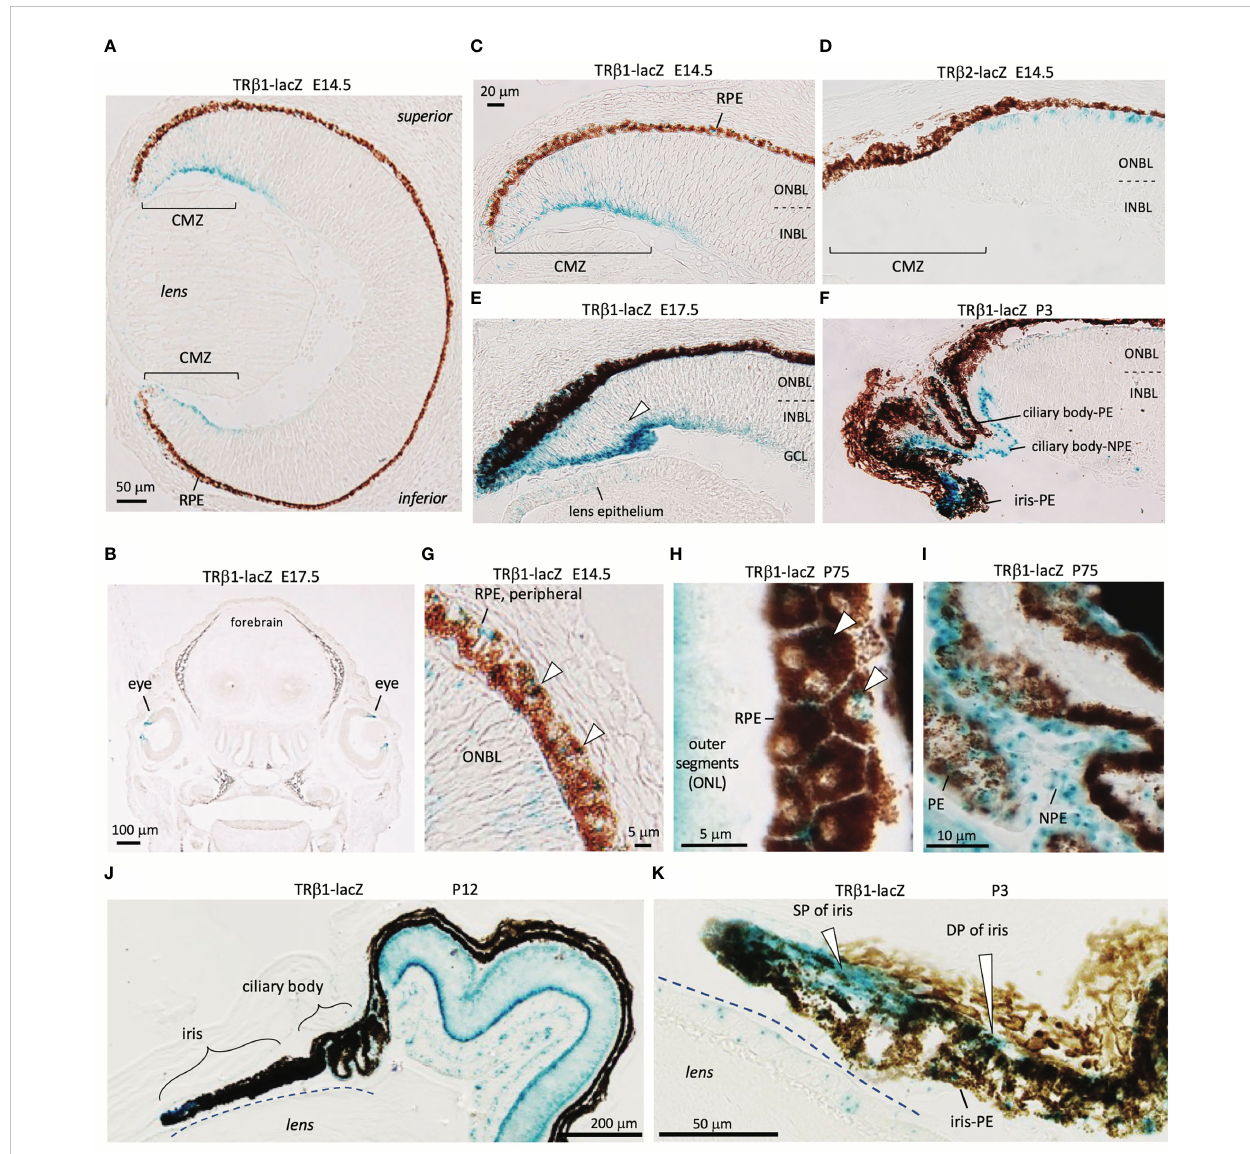
FIGURE 5 TR b 1 in the ciliary margin zone, iris and associated tissues detected in Thrb b1 lacZ reporter mice. (A, B) , TR b 1 in the ciliary margin zone (CMZ) (x-gal staining, blue) in Thrb +/b1 embryos. Otherwise, expression is rare in embryonic tissues (coronal head section in B ). (C, D) , Expression of TR b 1 in the CMZ contrasts with TR b 2 in cone precursors shown in Thrb b2/b2 lacZ reporter mice. (E) , TR b 1 in the late embryonic CMZ. Arrowhead, positive progenitor cells in the neuroblastic layers of the CMZ. Weak signals are detected in the lens epithelium. (F) , TR b 1 in the non-pigmented (NPE) and pigmented epithelia (PE) of the ciliary body at P3. (G, H) , TR b 1 in the retinal pigmented epithelium (RPE) (arrowheads) at embryonic (G) and mature (H) stages. Oblique section in H shows the planar polygonal shape of RPE cells. (I) , TR b 1 expression in NPE and PE of the ciliary body in the adult. (J, K) , Iris and ciliary body at P12 in overview (J) and iris at P3 at higher magni fi cation (K) . TR b 1 is detected in the sphincter pupillae (SP) and dilator pupillae (DP) and pigmented epithelium of the iris (iris-PE). CMZ, ciliary margin zone; GCL, ganglion cell layer; INBL, inner neuroblastic layer; NPE, non-pigmented epithelium of ciliary body; ONBL, outer neuroblastic layer; ONL, outer nuclear layer; PE, pigmented epithelium of ciliary body; RPE, retinal pigmented